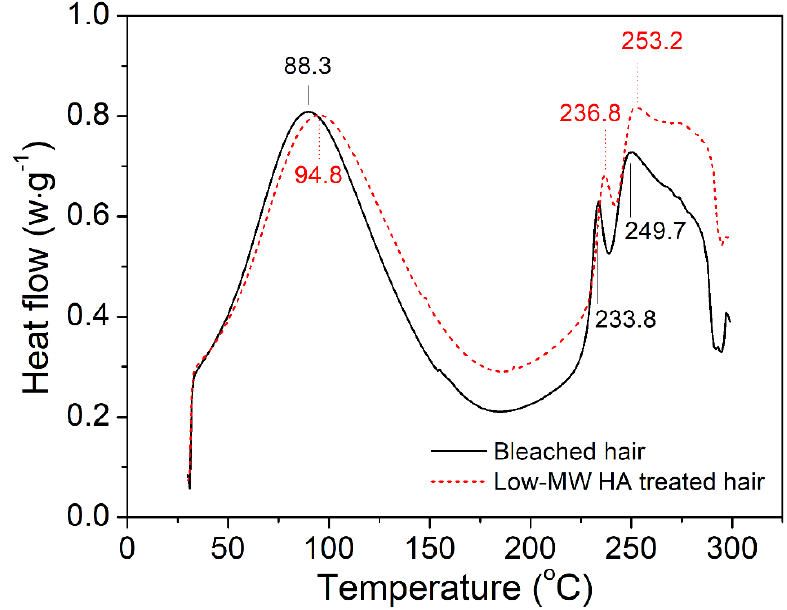
Figure 6. DSC spectra of untreated bleached hair and low-MW HA-treated hair.